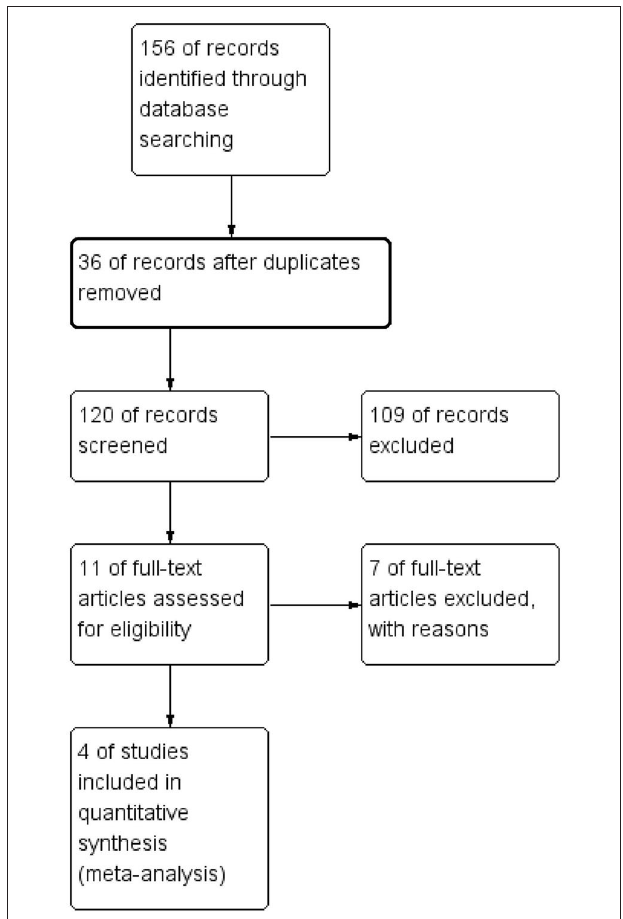
FIGURE 1 | Study flow